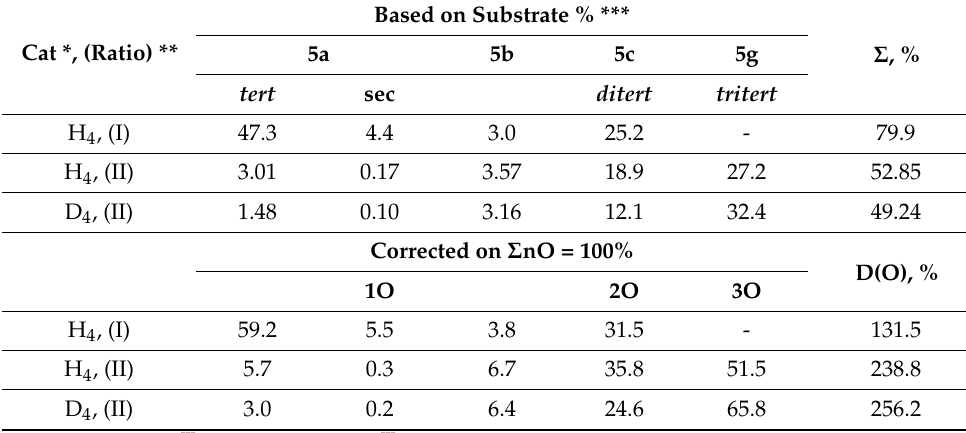
Table 2. Distributions of oxidation products of 5 before and after